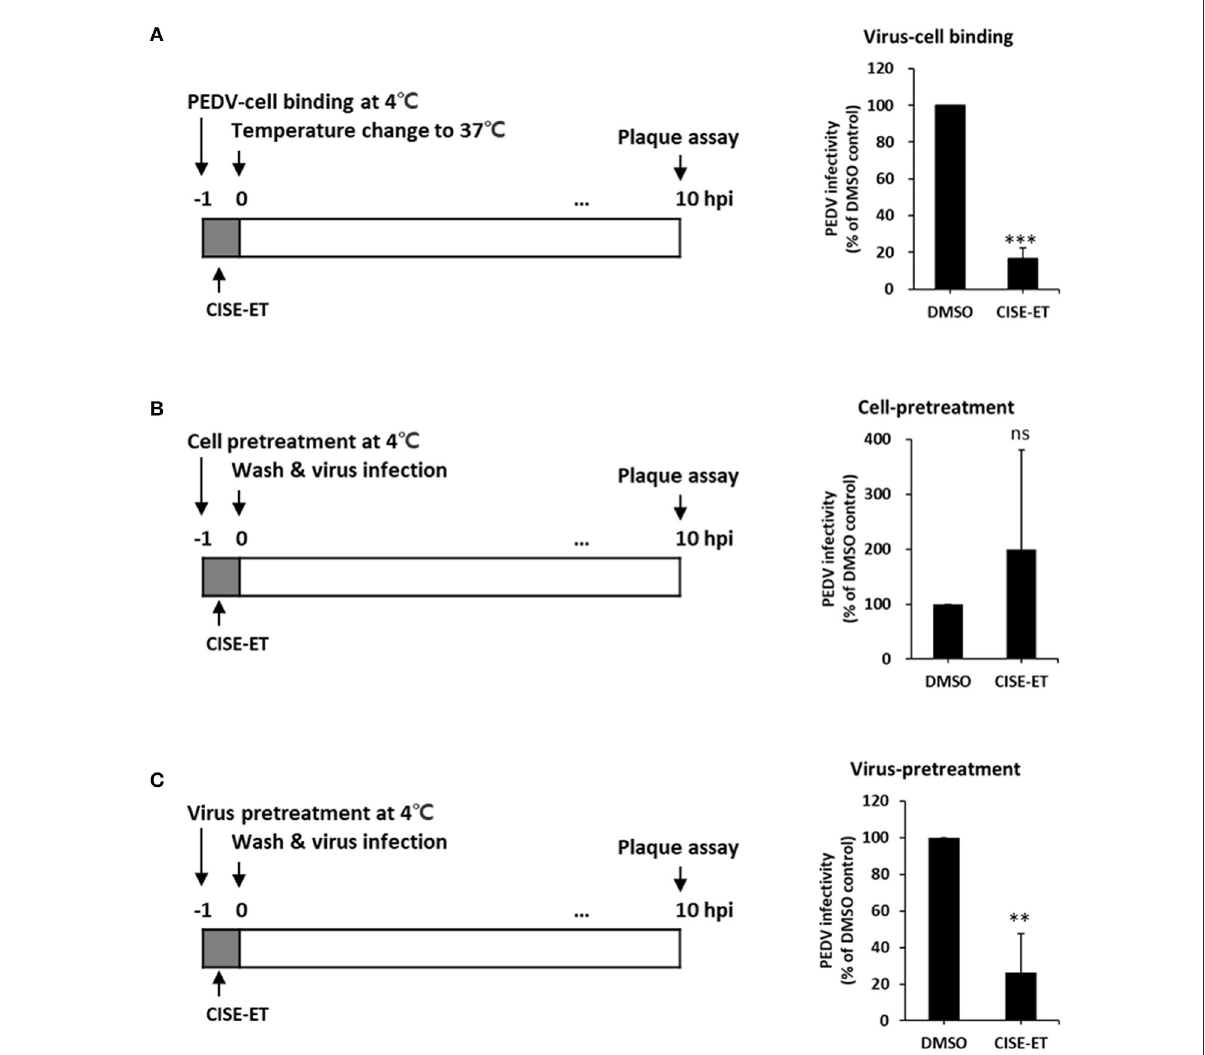
FIGURE4 CISE-ET blocked virus–cell binding by inactivating PEDV particles. (A) Vero cells were infected with PEDV (MOI = 1), treated with 30 µ g/ml CISE-ET at 4 ◦ C for 1h, washed with PBS, and maintained in SFM for 10h. (B) Vero cells were treated with 30 µ g/ml CISE-ET at 4 ◦ C for 1h, washed with PBS and infected with PEDV (MOI = 1) at 37 ◦ C. After 2h, the cells were washed with PBS and maintained in SFM for 8h. (C) PEDV was incubated with 30 µ g/ml CISE-ET at 4 ◦ C for 1h and then diluted in SFM 10-fold. Vero cells were then infected with diluted PEDV (MOI = 1) at 37 ◦ C for 1, washed with PBS and maintained in SFM for 8h. At 10 hpi, the virus titers were measured by plaque assay. The viral infectivity is expressed relative to that found for the DMSO control group. The error bars represent the SDs from the means ( n = 3). ** P < 0.01; *** P < 0.001; ns, not